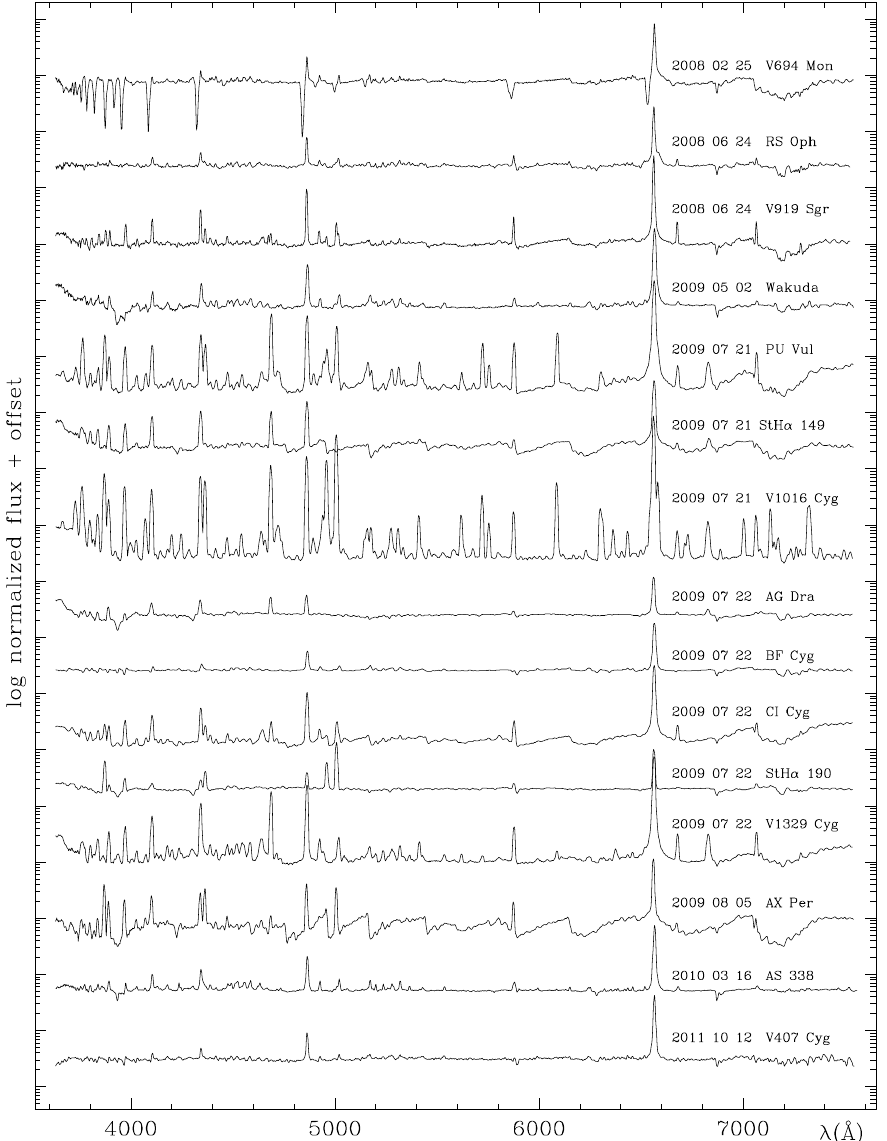
Fig. 2. A set of 15 spectra of symbiotic stars obtained with the refurbished 1.22 m Galileo Telescope. The spectra are absolutely flux calibrated and normalized. An offset has been applied for a better displaying. Dates of acquisition are also